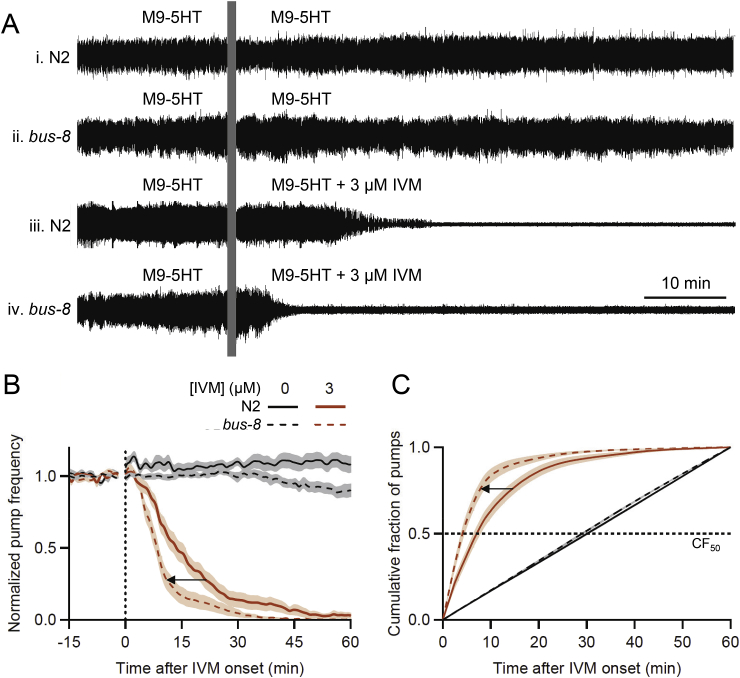
bus-8 (disrupted cuticle and epidermis) worms are more sensitive to IVM than N2s. Chips used for both strains were pre-treated with Pluronic F-127 to facilitate loading bus-8 worms, which adhere to PDMS (see Section 2.5). A. Representative EPG recordings from individual worms, all perfused with M9-5HT during the baseline period. i, ii, N2 and bus-8 worms switched to M9-5HT (controls); iii, iv, N2 and bus-8 worms switched to 3 μM IVM in M9-5HT. IVM inhibited pumping more rapidly in bus-8 than in N2 worms. B. Normalized pump frequency (see Section 2.6) plotted against time for N2 and bus-8 worms switched to 3 μM IVM (mean ± S.E.M.; n = 18–29 worms/group). The key in B applies to B and C. Arrow denotes leftward shift of pump frequency plot for bus-8 compared to N2 worms, indicating increased sensitivity to IVM. C. Same data as B, plotted as the cumulative fraction (CF) of pumps occurring over time after perfusate switch at t = 0 min. Dotted line denotes CF50, the intercept at which statistical comparisons were made. CF50 median values were (N2, bus-8, respectively, in minutes): 0 μM IVM, 30.1, 29.3; 3 μM IVM, 7.7, 4.2. Arrow denotes leftward shift of CF plot in bus-8 relative to N2s.